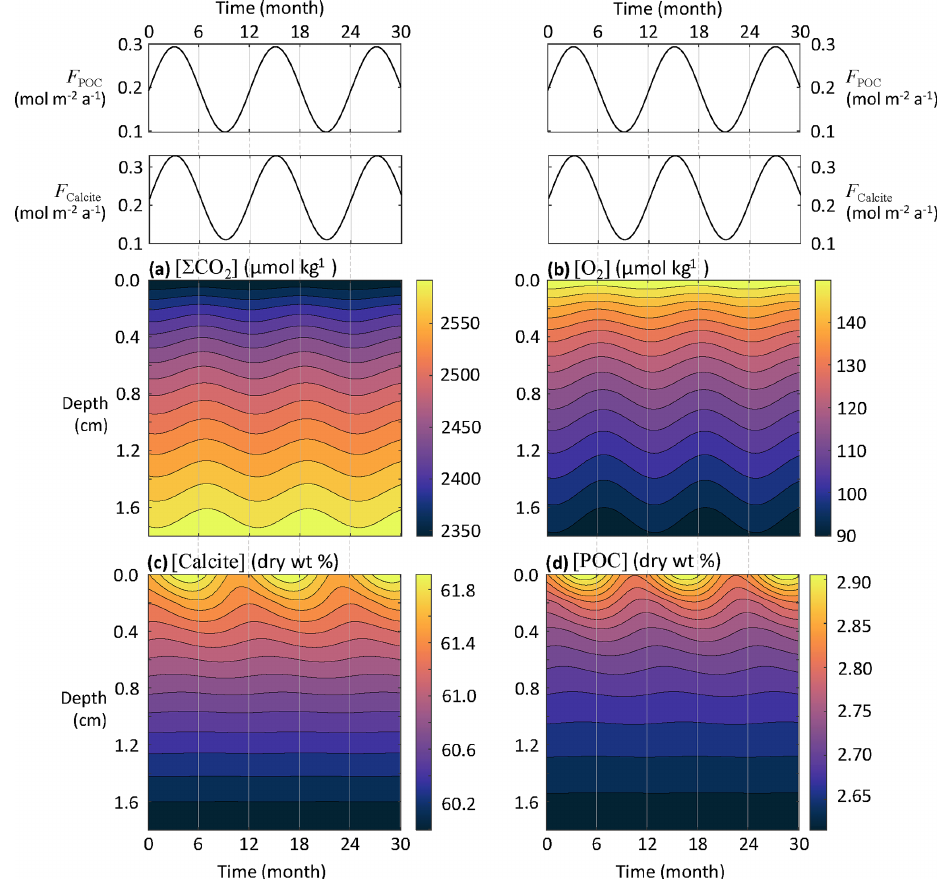
Figure 7. Response of porewater O 2 , (cid:54) CO 2 , calcite, and POC concentrations to seasonal fluctuations in the calcite and POC fluxes reaching the